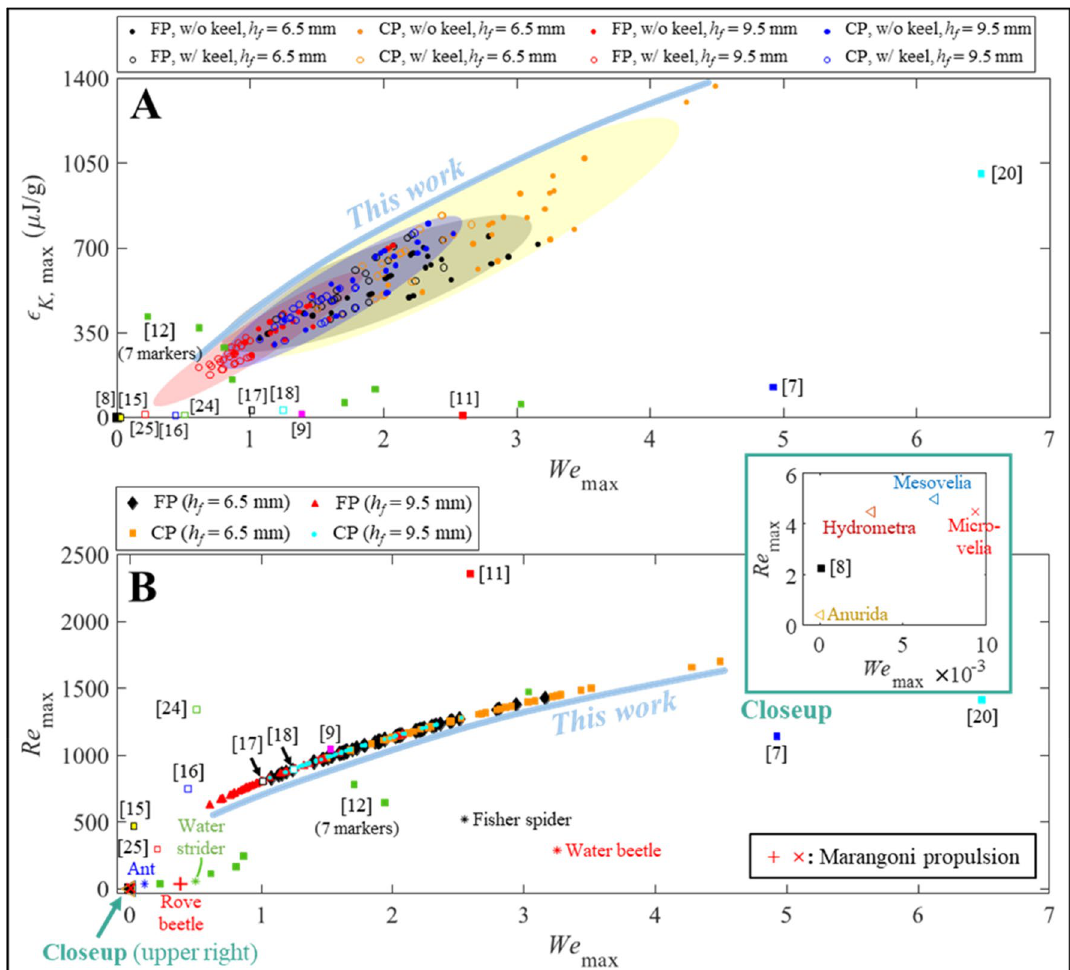
Figure 7. Robot locomotory characteristic using nondimensional numbers. ( A ) ε K , max versus We max . Error eclipses include 95% confidence intervals. Identical coloration of markers and eclipses indicate the use of identical porous media and h f values. ( B ) Re max versus We max . Biological data were obtained from 2, 53–57 , and no distinguish was made between keeled and pristine